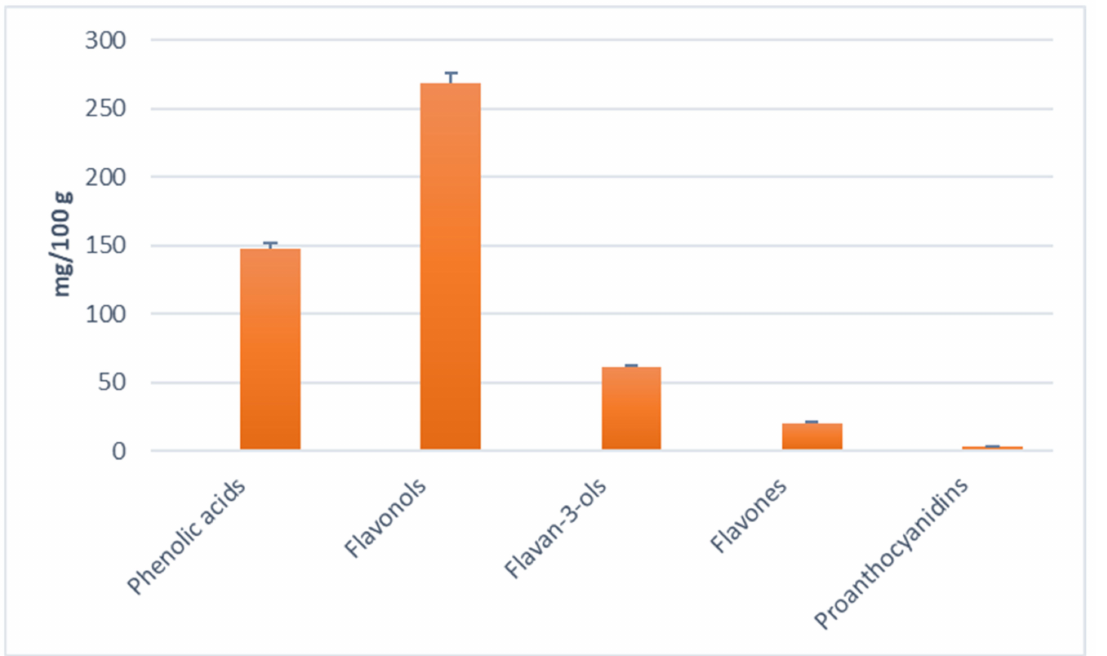
Figure 2. Concentration of different groups of polyphenols determined in the laurel leaf extract obtained at optimal PLE